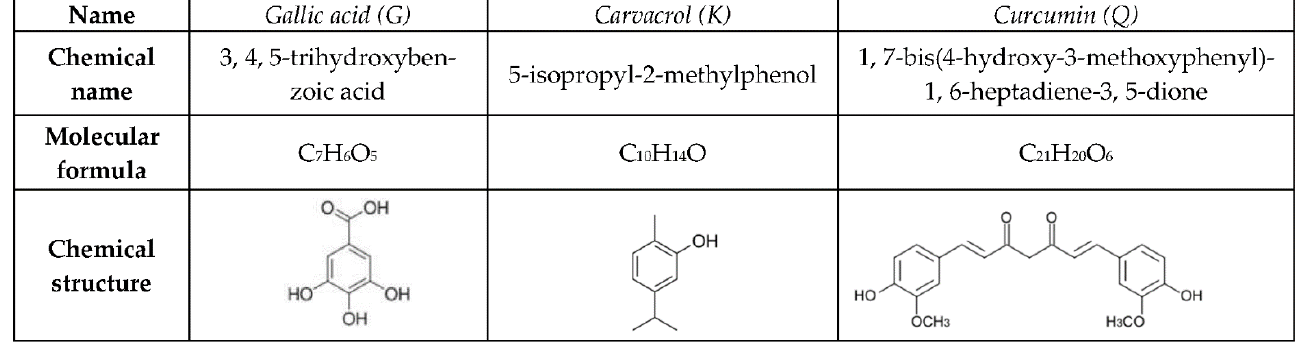
Figure 1. Chemical name, molecular formula and chemical structure of the three active molecules selected: gallic acid (G), carvacrol (K) and curcumin (Q).